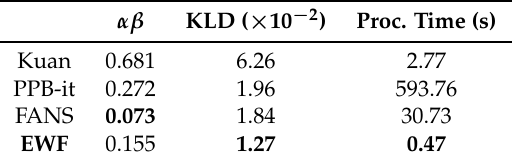
Table 4. Measures for the real Chicago City SAR